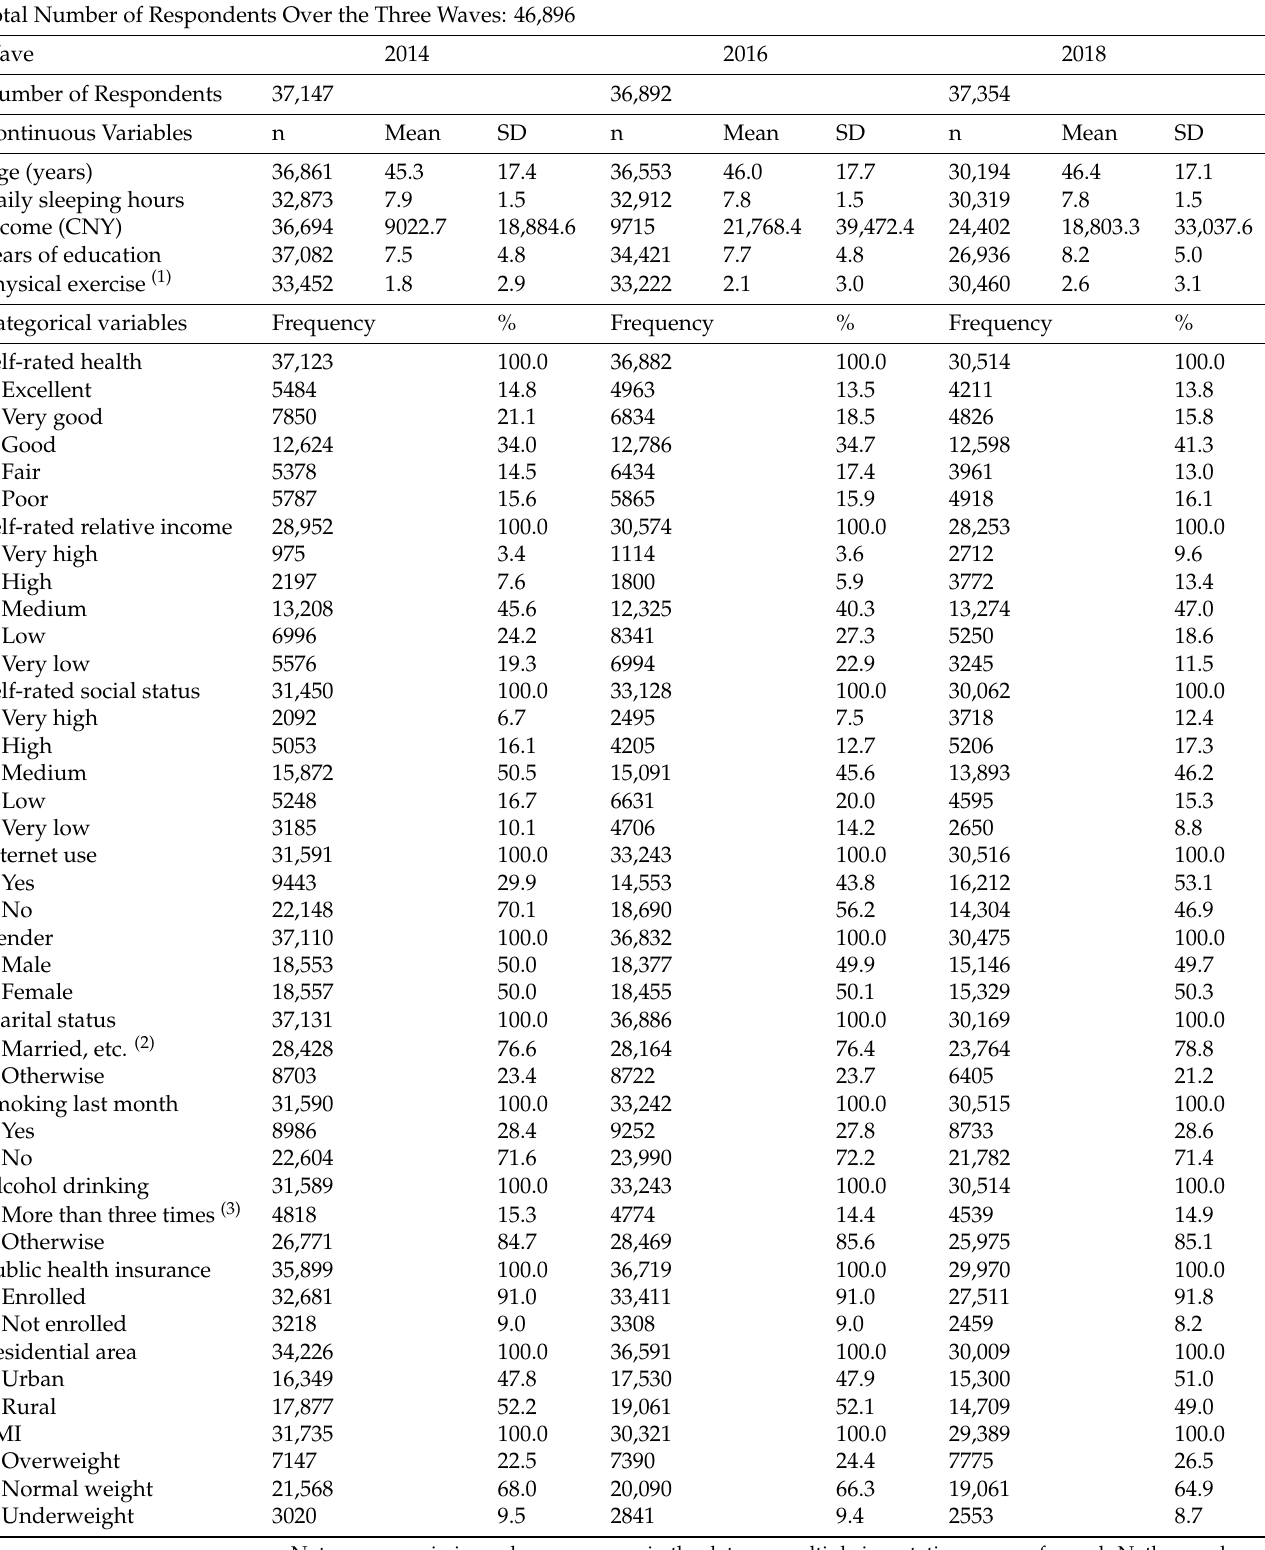
Table 1. Descriptive statistics before multiple